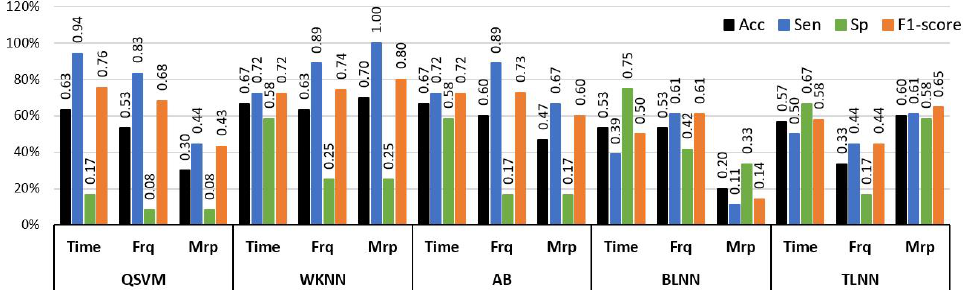
Figure 8. Performance evaluation with time, frequency (Frq), and morphological (Mrp) features using different classifiers for Experiment 2 (No Pain vs. Low Pain). (QSVM: Quadratic-SVM, WKNN: Weighted-KNN, AB: AdaBoost, BLNN: bi-layered neural network, TLNN: tri-layered neural network).